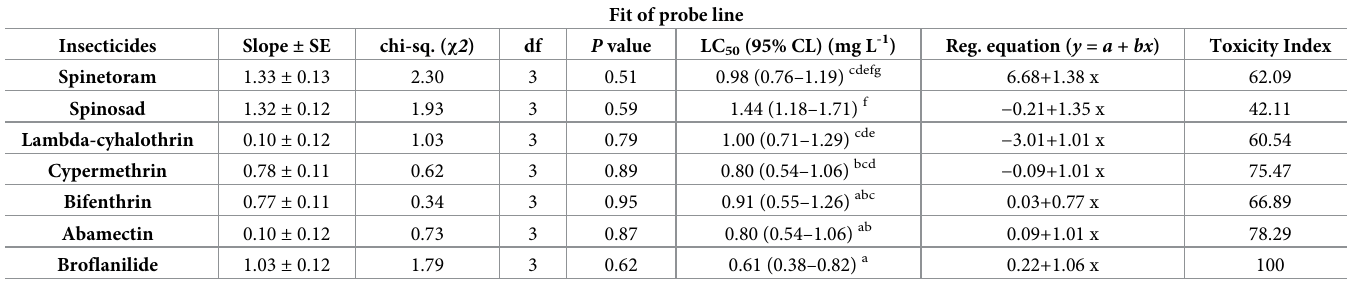
Table 7. Susceptibility of the second instar S . frugiperda larvae to synthetic insecticides at 72 h